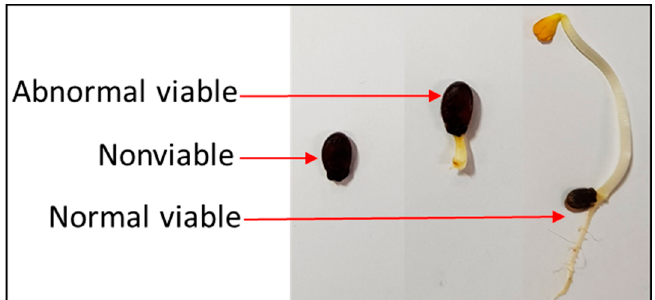
Figure 5. Types of seed found in germination test.